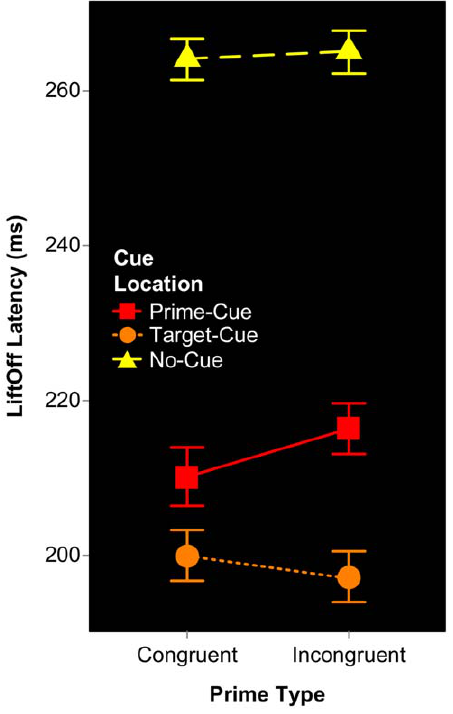
Figure 2. Conditional mean LiftOff Latencies for Expt 1A. Subjects began their reaching movement earliest when the exogenous cue captured attention to the target’s location. Prime Type had no effect on when subjects began their reaching